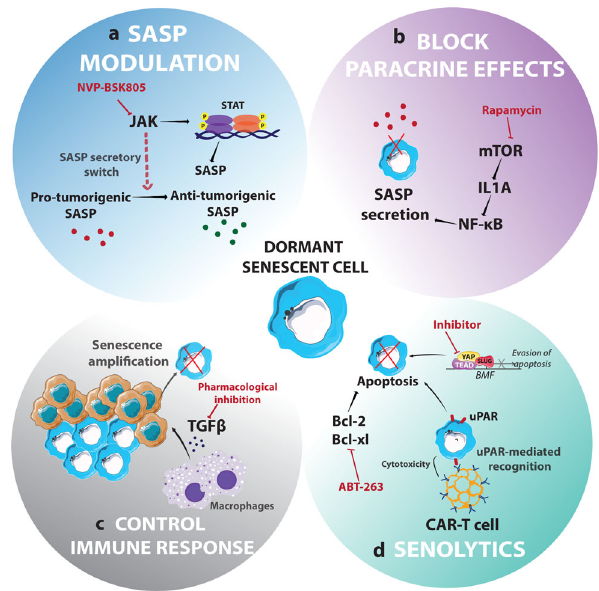
Fig. 3 Schematic representation of the different strategies to eradicate dormant senescent cancer cells. Strategies to eradicate dormant senescent cancer cells have been classi fi ed in four groups: since senescent cancer cell activity is mainly directed via SASP secretion, two different approaches can be done a SASP modulation; b blocking the paracrine effects of SASP; c control the immune response in order to avoid senescence ampli fi cation; d use senolytic compounds that directly target senescent